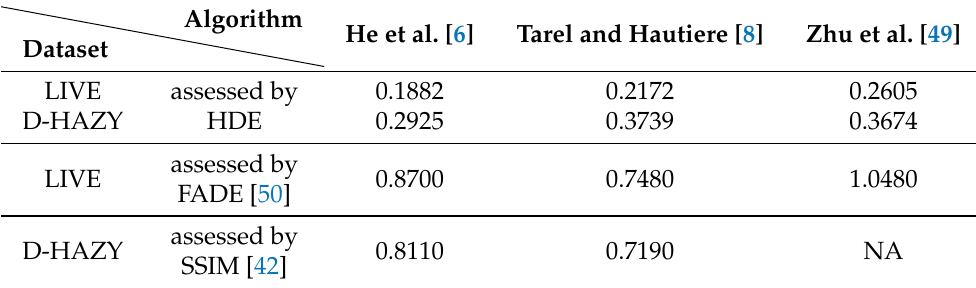
Table 6. Quantitative evaluation results of dehazing algorithms on LIVE and D-HAZY datasets. NA stands for not